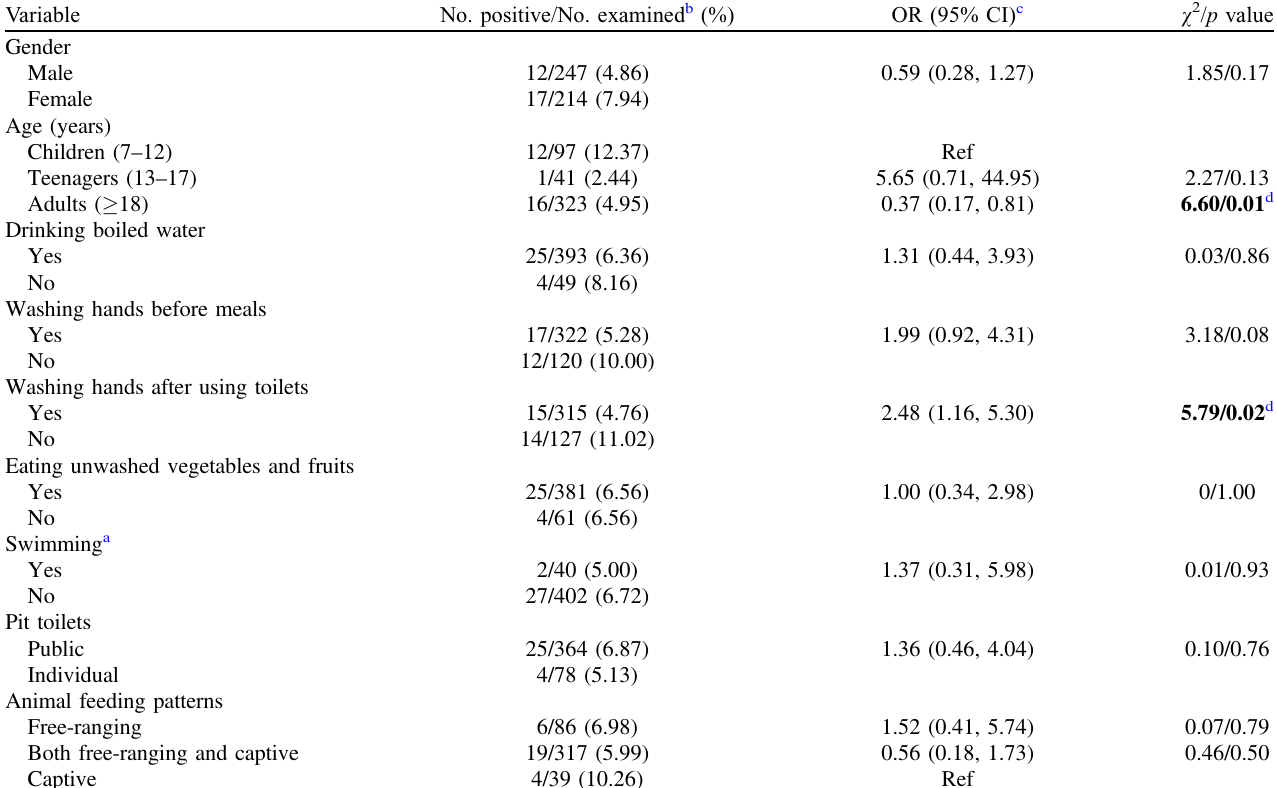
Table 1. Assessment of possible risk factors for Blastocystis carriage. Variable